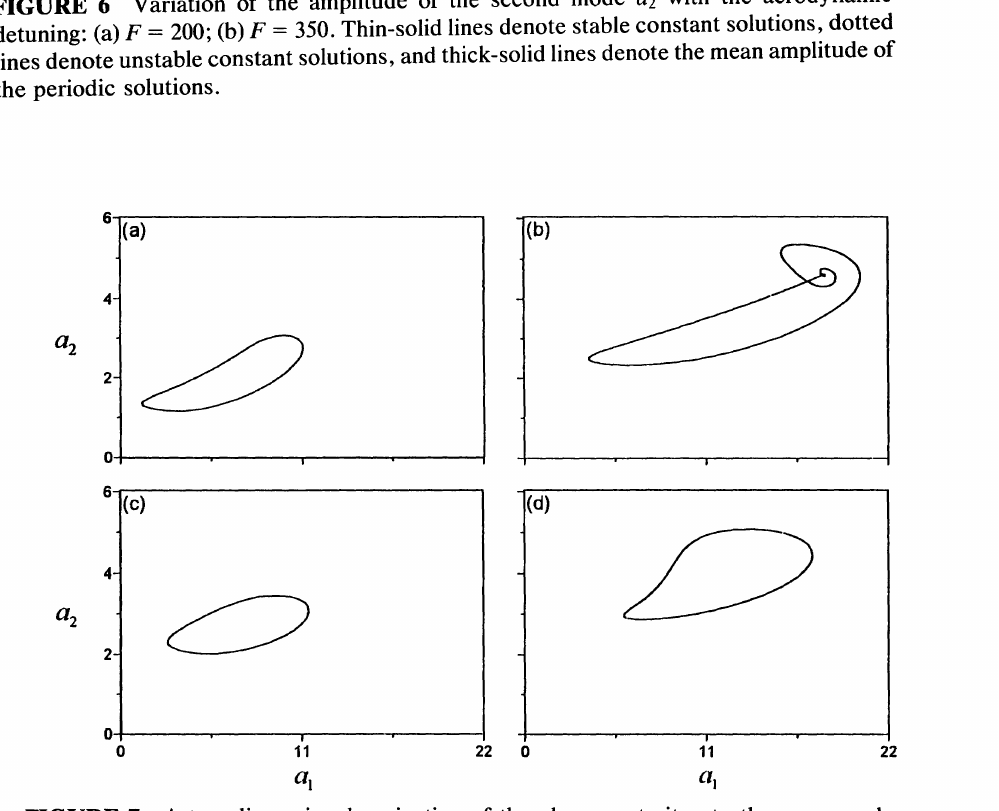
FIGURE 7 A two-dimensional projection of the phase portrait onto the a2 - at plane: (A, F) = (a) (679.2, 340); (b) (1000, 340); (c) (679.2, 200); and (d) (1000,